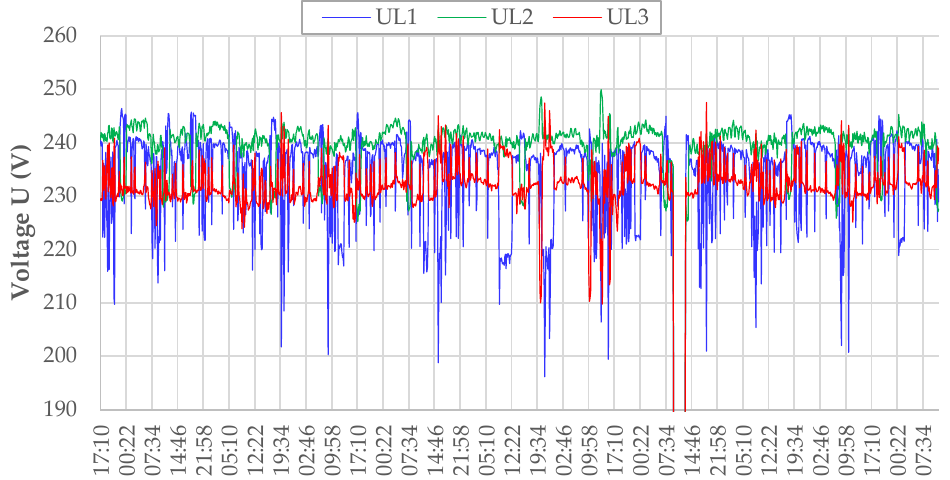
Figure 11. Voltage measurements according to standard EN 50160 at Object 2 (three phases, average of 10-min intervals).